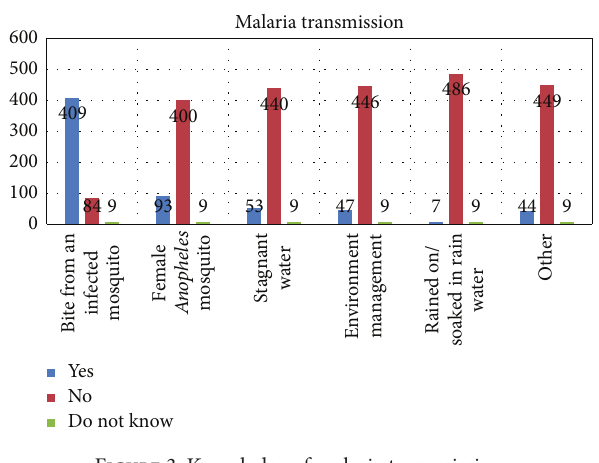
Figure 3: Knowledge of malaria transmission.